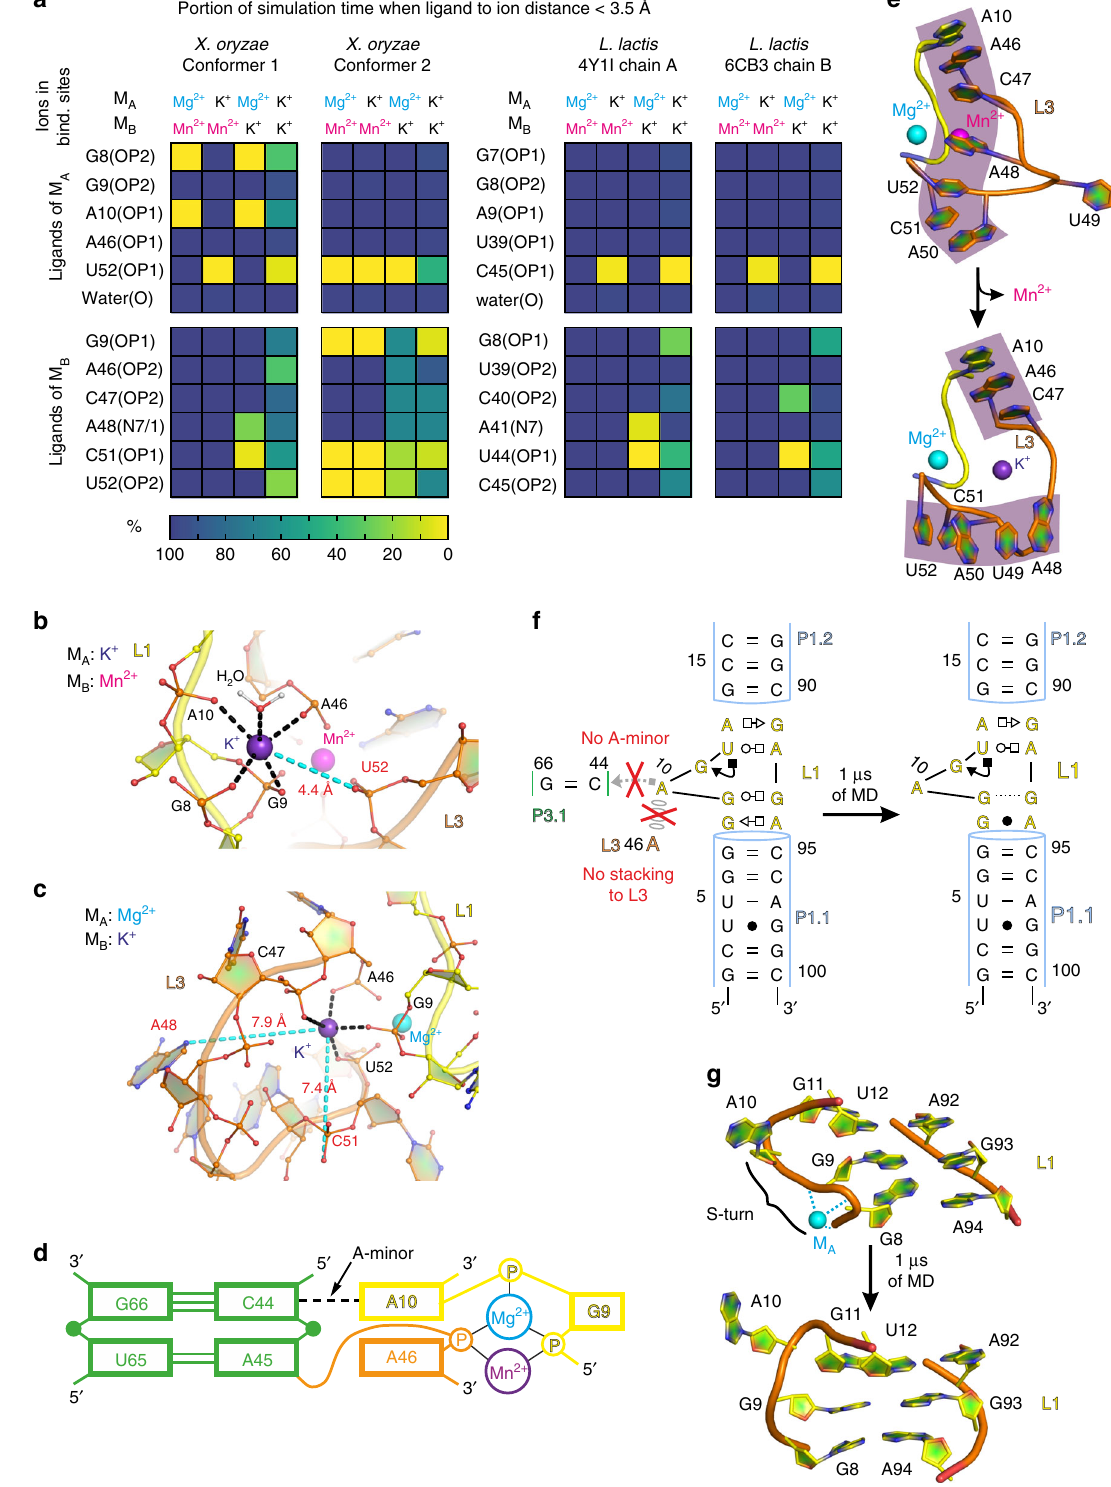
Fig. 3 Structural dynamics of inner-shell ligands of the M A,Mg and M B,Mn sites, L3 and L1 loops as revealed by MD simulations. a The population of native inner-shell contacts in the M A,Mg and M B,Mn sites in percent as a function of the type of ion in these sites. A representative structure of the b M A,Mg and c M B,Mn site as typically observed in MD simulations with a K + ion occupying the site. The most labile inner-shell contacts are depicted in cyan. d 2D representation of the most stable part of the L1 – L3 tertiary interaction that is likely anchored by the A-minor interaction and related A10|A46 stacking. e Partial unfolding of the stacking pattern in the L3 loop observed upon replacement of Mn 2 + with K + in the M B,Mn site. f The loss of native G9 – G93 trans Watson-Crick/Hoogsteen and G8 – A94 trans Sugar-Edge/Hoogsteen base pairing, and g loss of the S-turn backbone conformation involving a phosphate notch forming part of the M A,Mg ion binding site in response to loss of the L1 – L3 tertiary interaction with its A10 … G66 = C44 A-minor